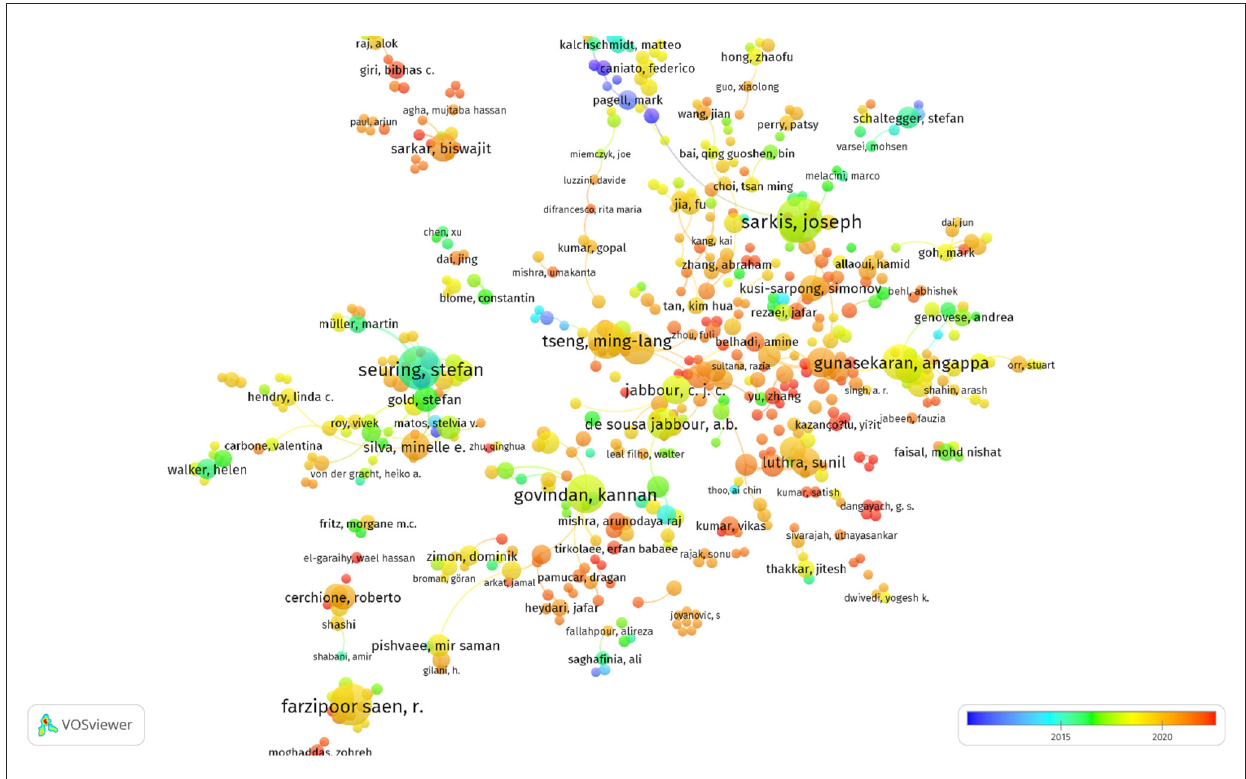
FIGURE4 Co-authorship network